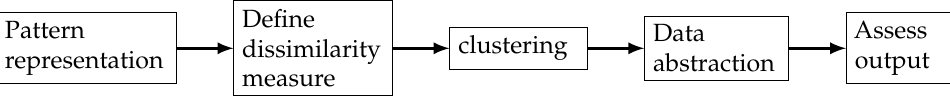
Figure 2. A typical data clustering